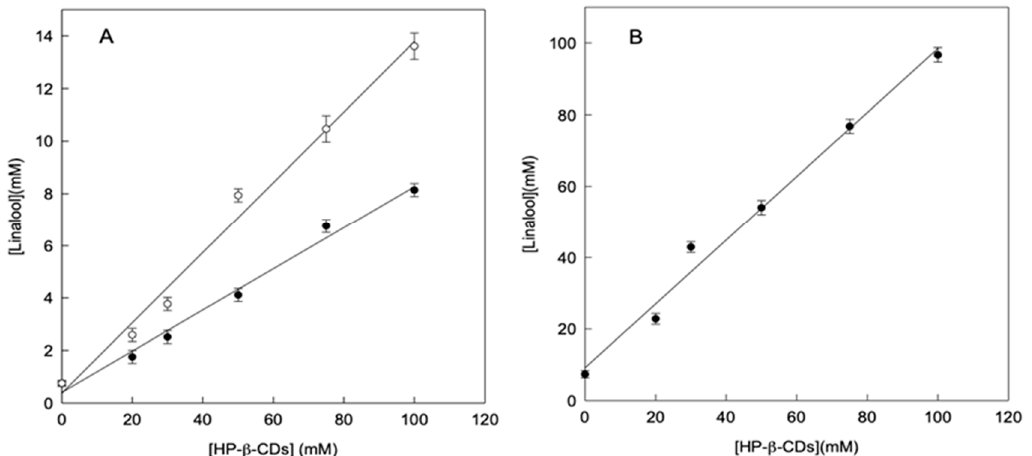
Figure 2. Phase solubility diagrams of linalool with HP- β -CDs a pH 7.0 by using microwave as energy source 24h MWI ( ○ ) and 48h MWI ( ● ) ( A ), by using ultrasounds as energy source ( B ). Values represent means of triplicate determination.